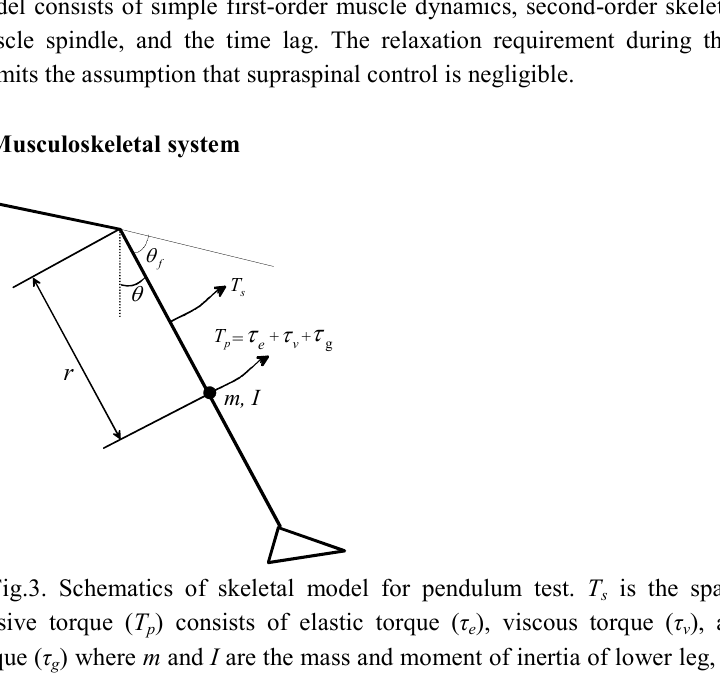
is the spastic torque. The s ), viscous torque ( τ ), and gravitational e v